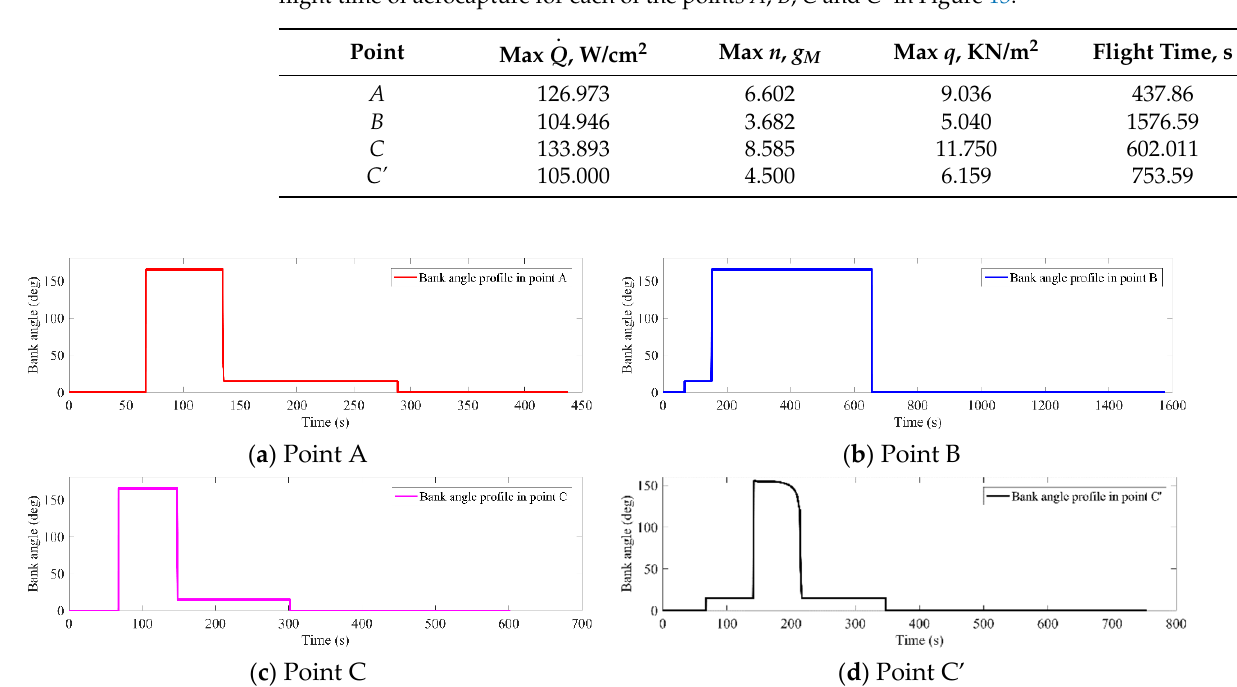
Figure 14. Bank angle profiles for each of the points A , B , C , and C ′ in Figure 13.